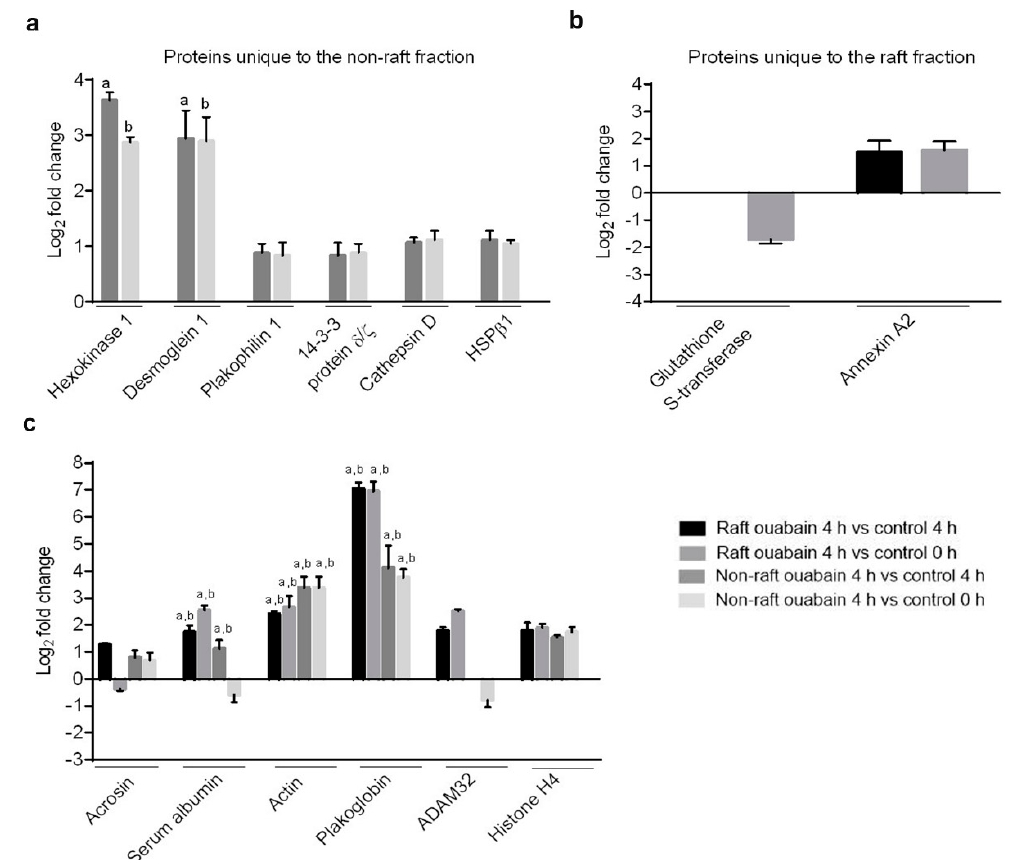
Figure 1. Interactome profile of ATP1A4 in raft and non-raft fractions of control (control 4 h and control 0 h) and ouabain-capacitated sperm. ( a ) Fold change of upregulated proteins that interacted with ATP1A4 in non-raft fraction. ( b ) Fold change of upregulated and downregulated proteins that interacted with ATP1A4 in raft fraction. ( c ) Fold change of upregulated and downregulated proteins identified in both fractions. a Significant ( p < 0.05) difference compared with control 4 h group with a log 2 FC >2; b Significant difference compared with control 0 h group with a log 2 FC >2.